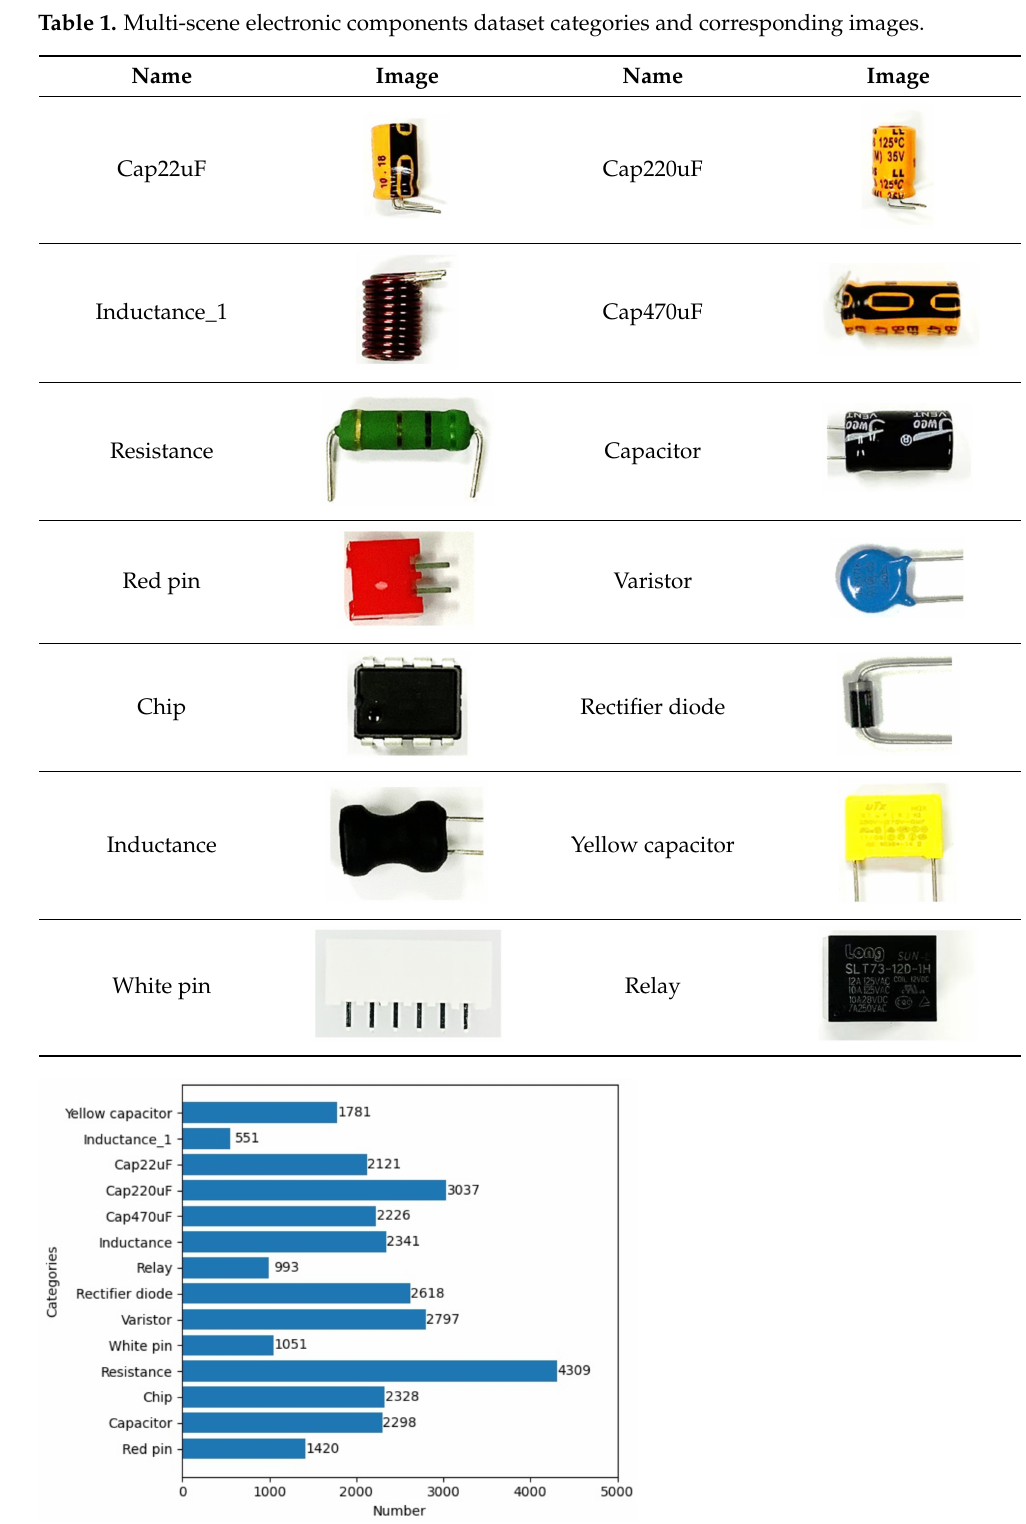
Figure 2. Categories and numbers on the multi-scene electronic components